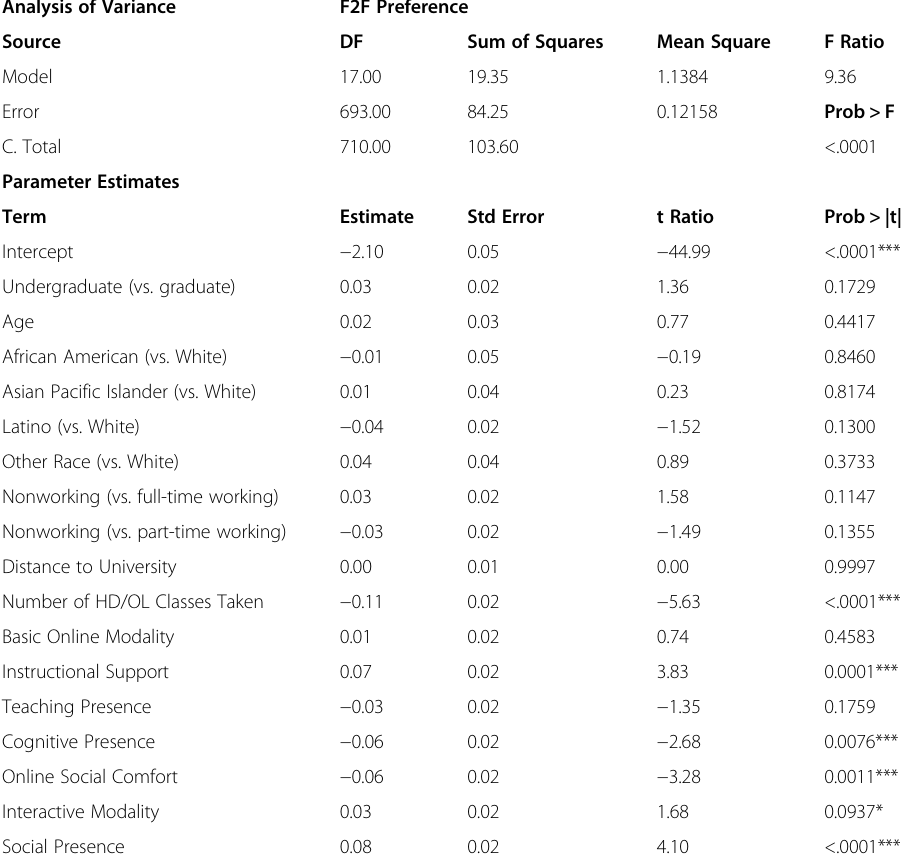
Table 8 Summary of Multiple Regression Analysis: F2F Preference Analysis of